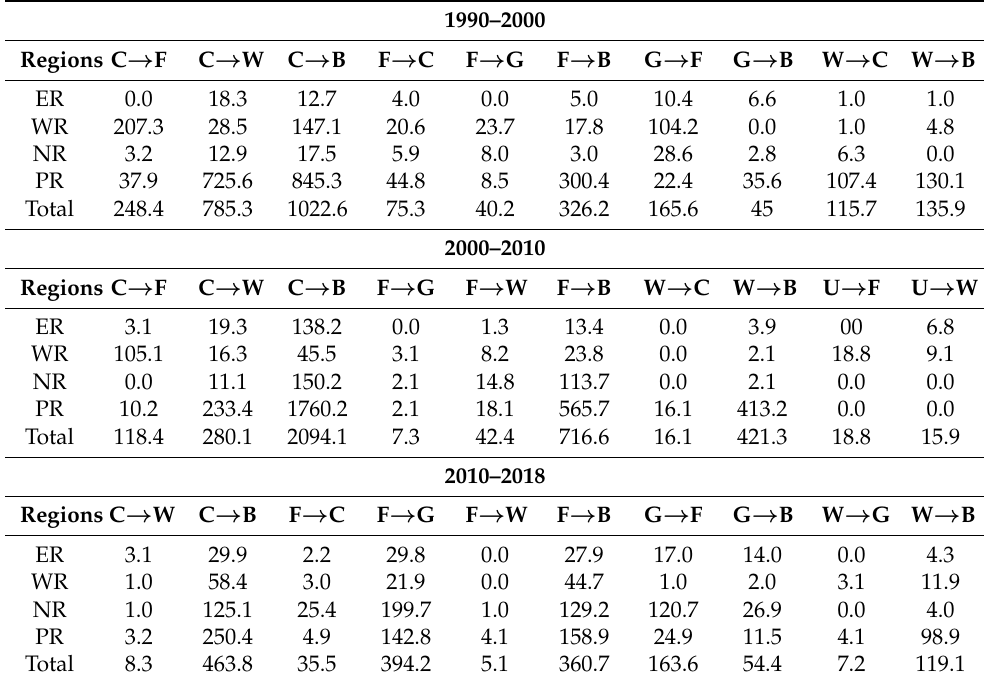
Table 6. Land-use transitions in the four regions of Guangdong from 1990 to 2018 (km 2